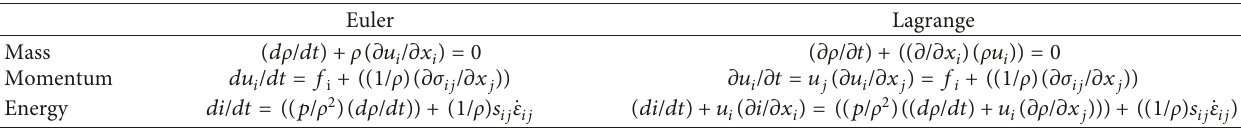
Table 7: Governing equations [104, 108,